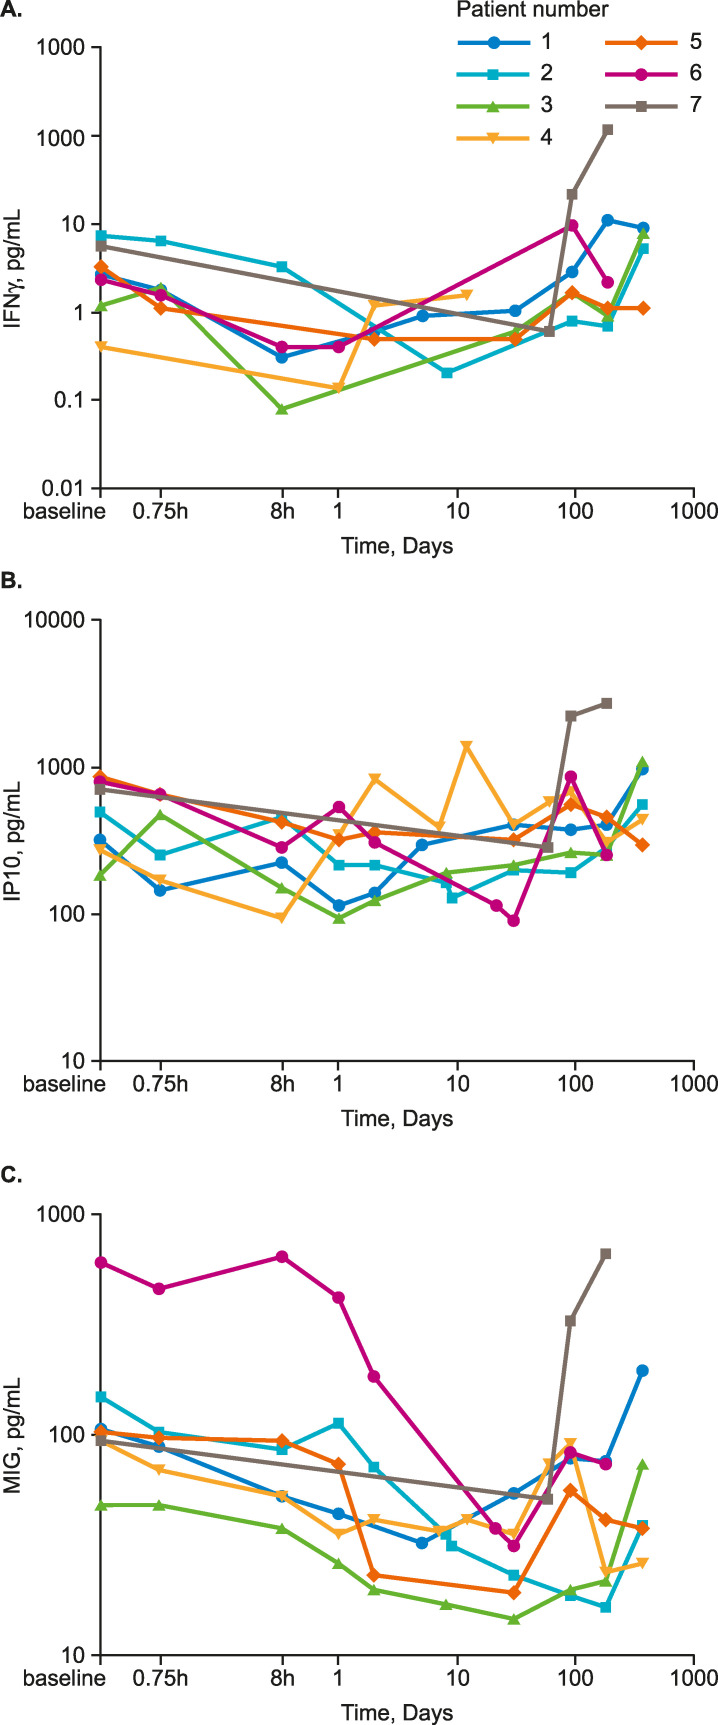
Serum cytokine levels over the study course.(A) IFNγ, (B) IP10, (C) MIG. IFNγ, interferon-γ; IP10, IFNγ-induced protein 10 Kd; MIG, monokine induced by IFNγ. Figures produced post-hoc.